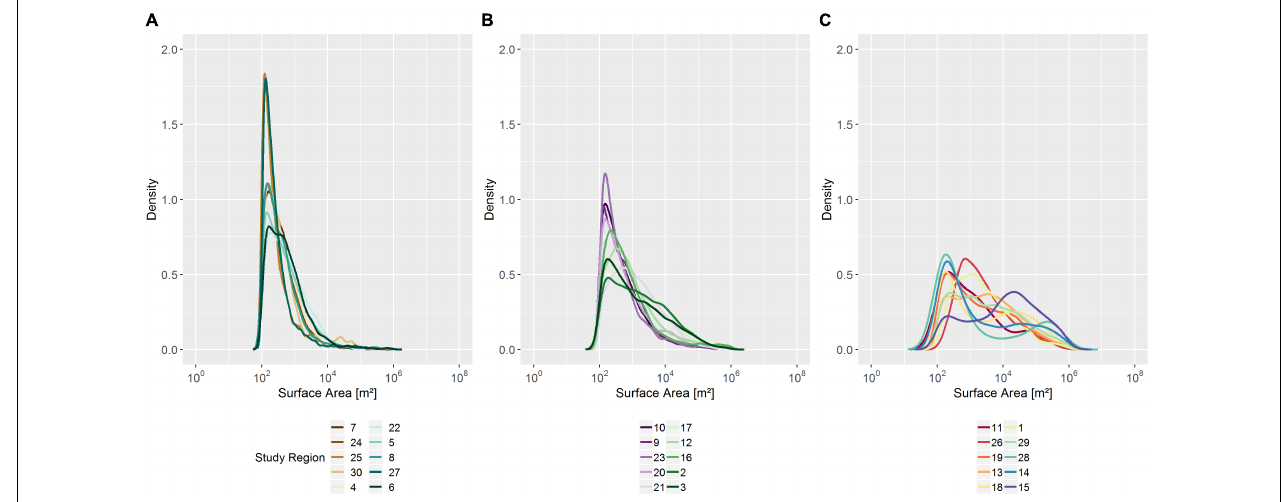
FIGURE 6 | (A–C) Probability density functions (PDF) for band-limited (0.0001 to 1 km 2 ) waterbody size distributions, for three groups of ten study regions. The X -axis is plotted on a logarithmic scale; the PDFs were calculated from log-transformed data. Study regions are sorted according to their mean waterbody sizes. For region numbers see Figure 1 and Supplementary Table 1 .